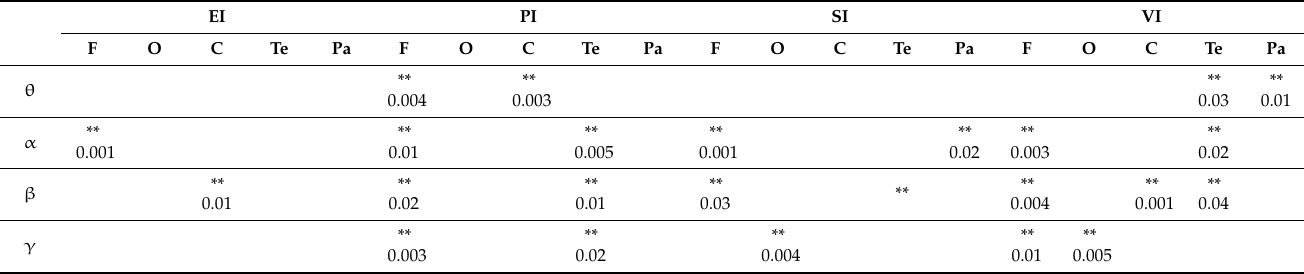
Table 5. Summary of ANOVA results extracted with respect to stimulus presentation paradigms, spectral bands, and brain regions. Statistical significance (** p <